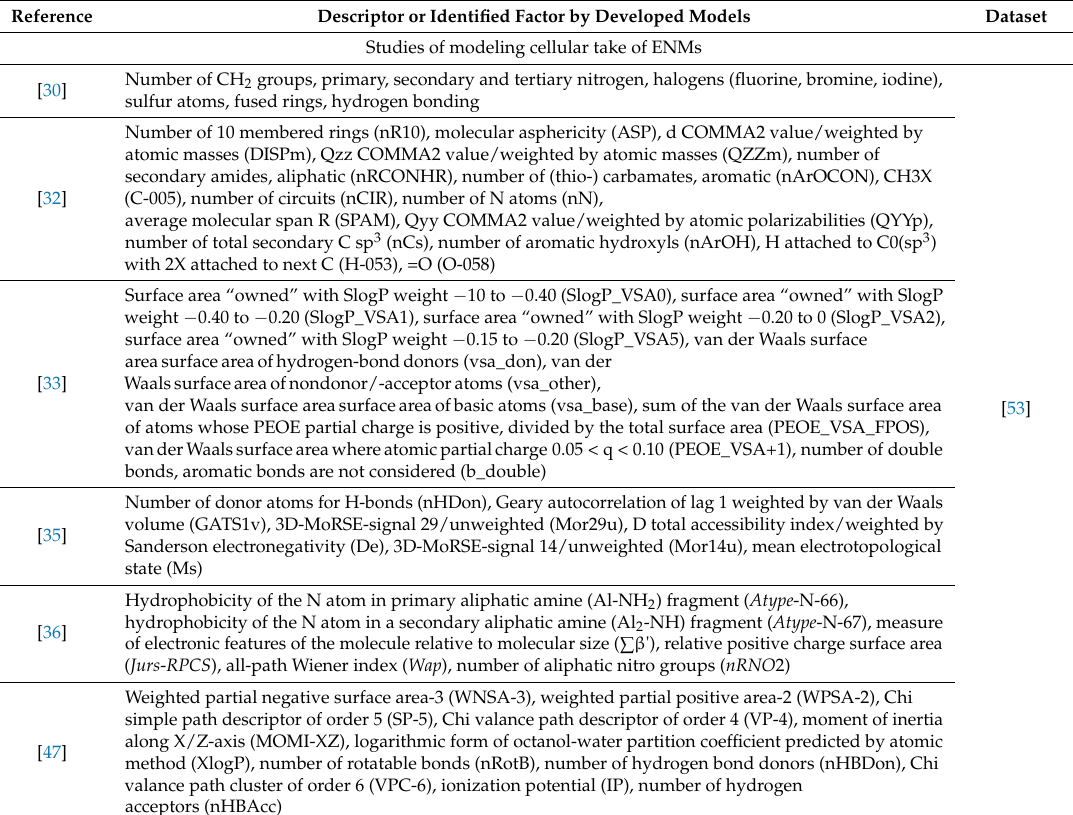
Table 6. Overview of computational descriptors or factors discussed in nano-(Q)SAR studies, including information on the original dataset for modeling. Name of the descriptors in original publications are given in the parenthesis (if